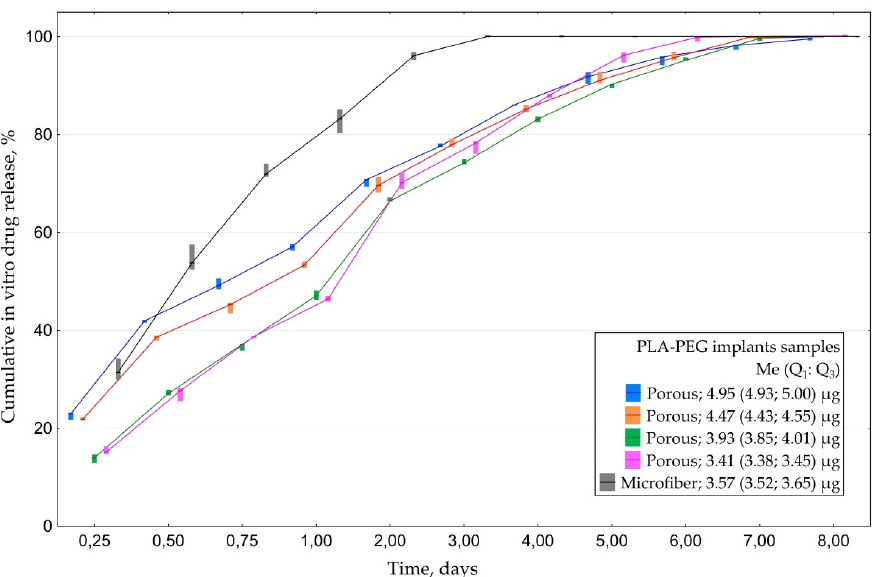
Figure 5 . Cumulative drug release of CsA from PLA-PEG implants samples depending on their